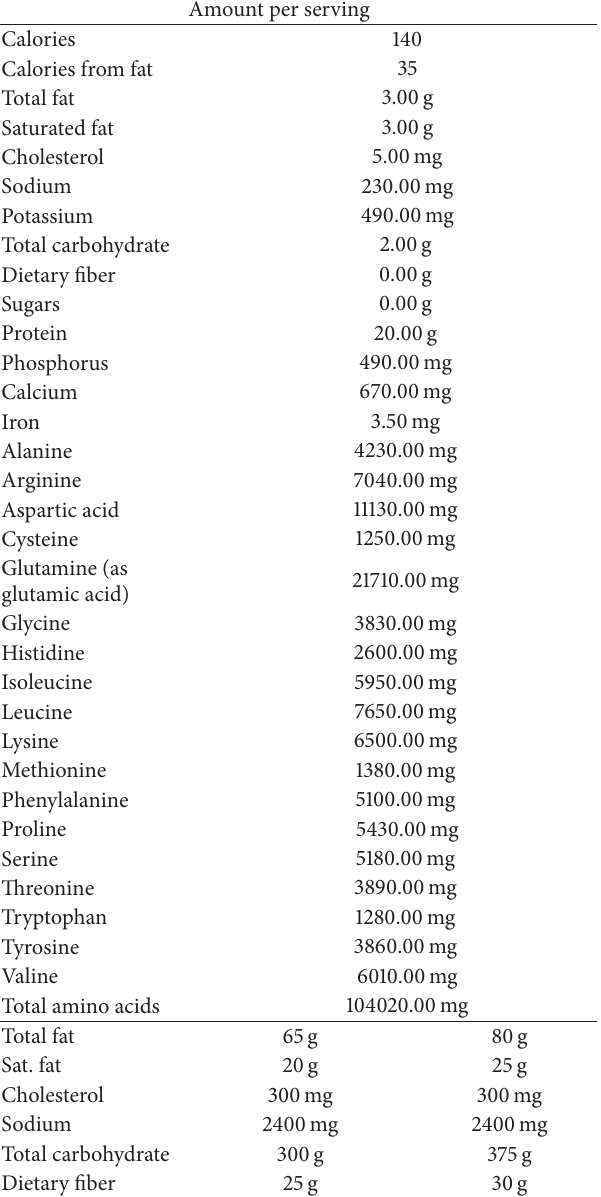
Table 3: Ingredient description of the used muscle building supple-